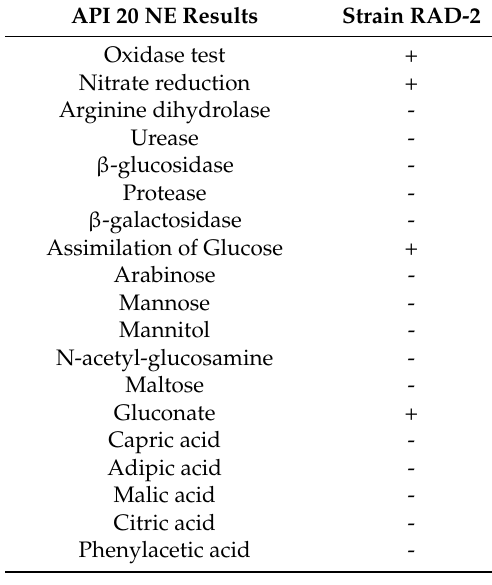
Table 1. Characteristics of strain RAD-2 determined by API 20 NE tests.